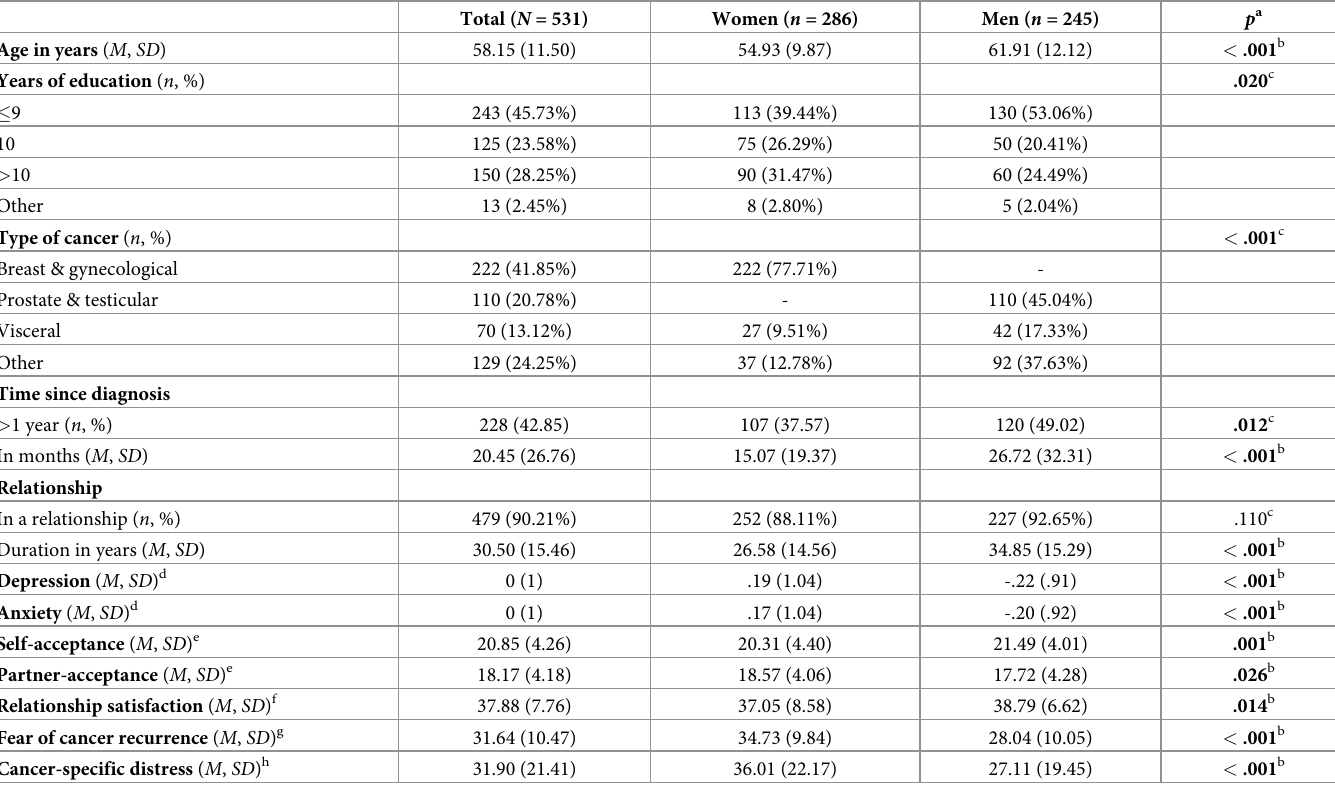
Table 1. Demographic characteristics of the total sample ( N = 531) and by